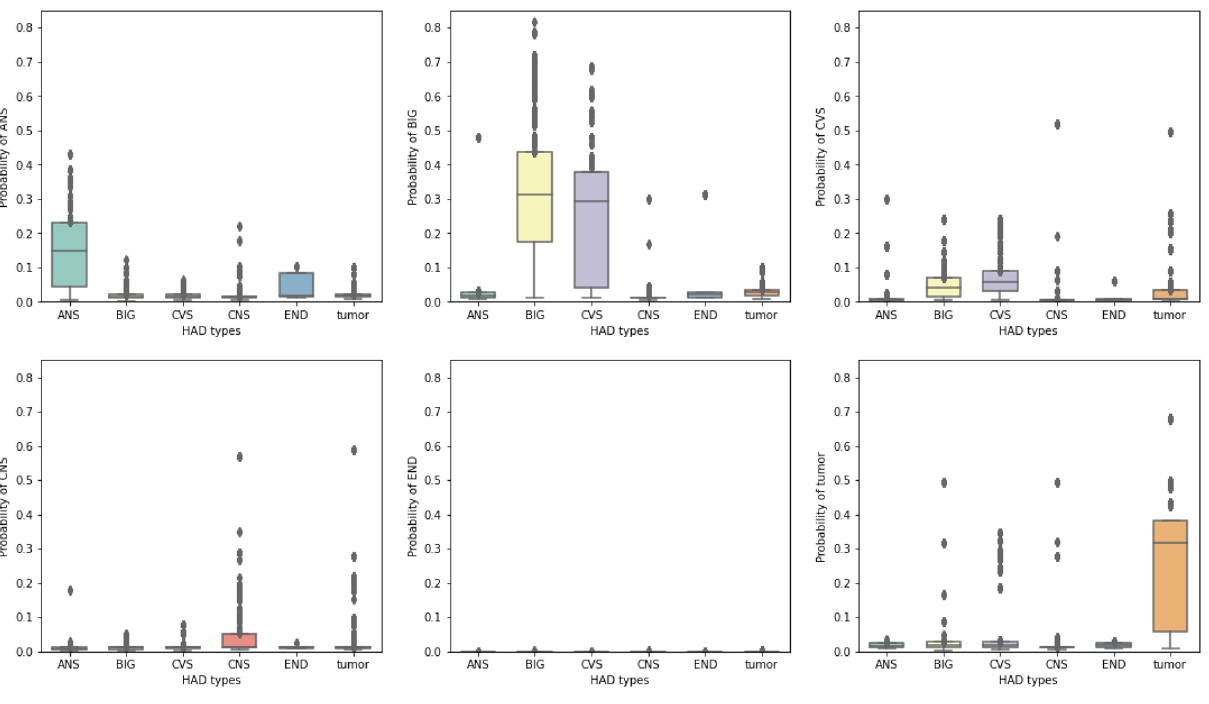
Figure 10. HAD type classification in OPD data